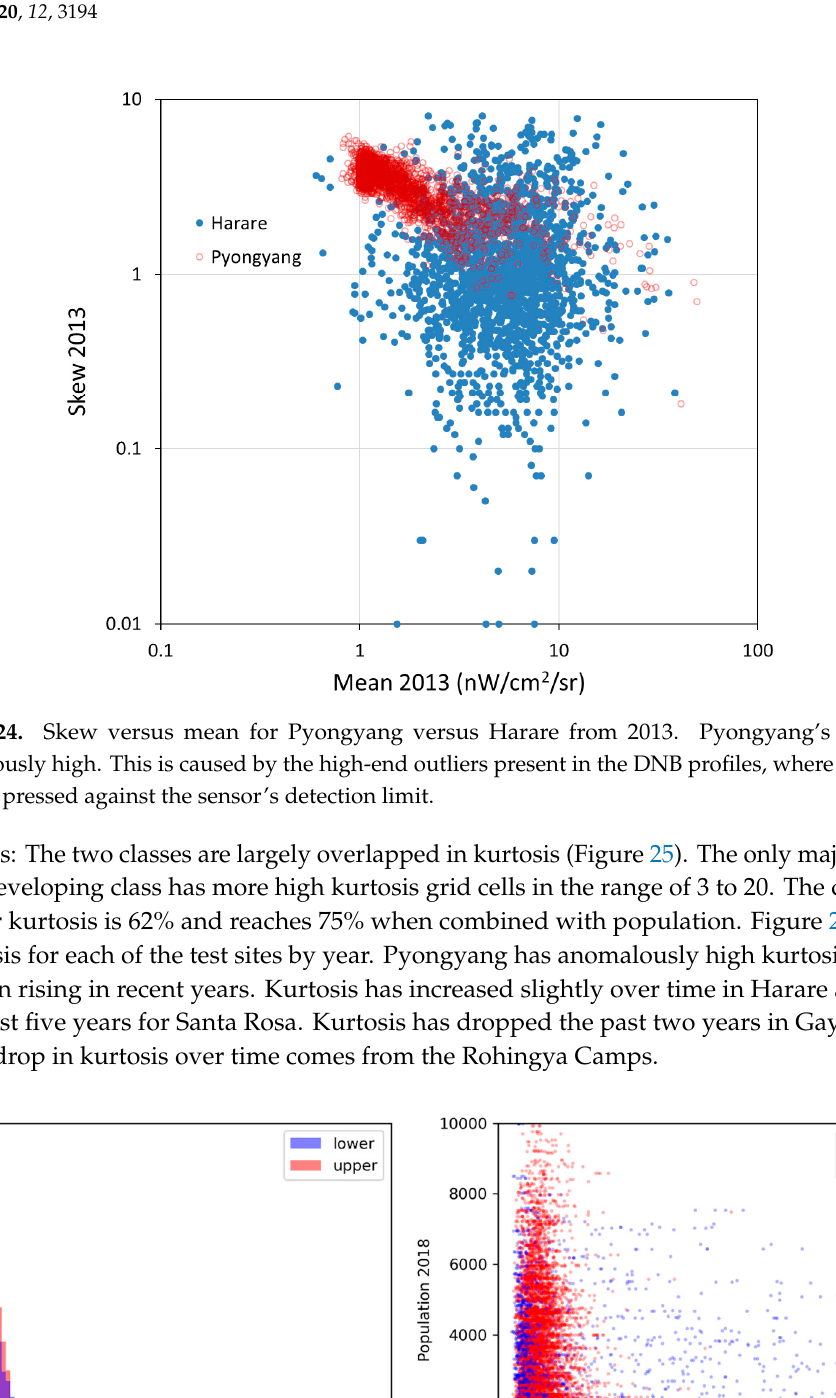
Figure 25. Histogram and scattergram of the 2018 kurtosis values for the developing set (Harare, Nairobi, Dhaka, and Pyongyang) versus the developed set (Houston, Seoul, Shanghai, Beijing). The developed set is red and developing set is blue. The two sets are referred to as “lower” and “upper”,